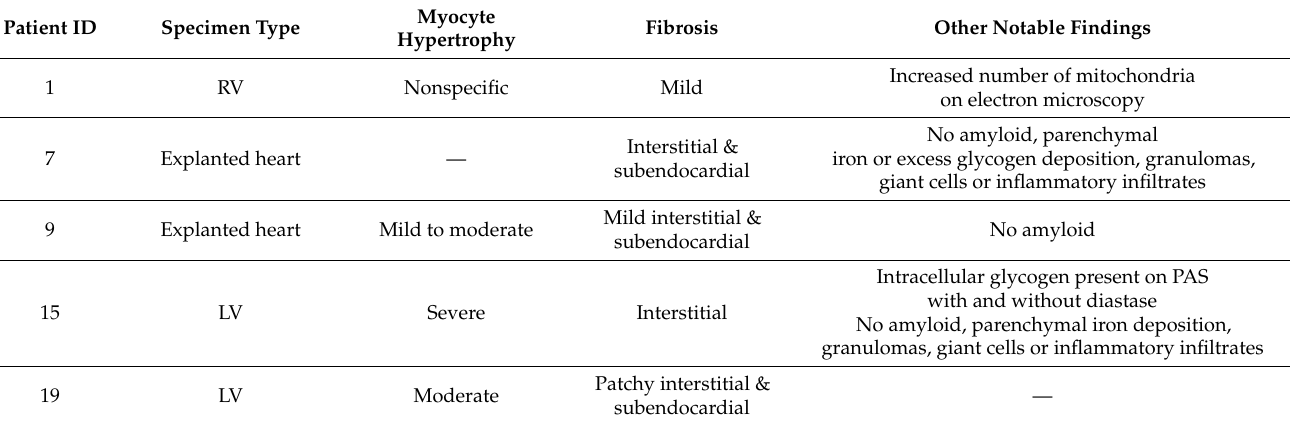
ventricle; PAS = Periodic